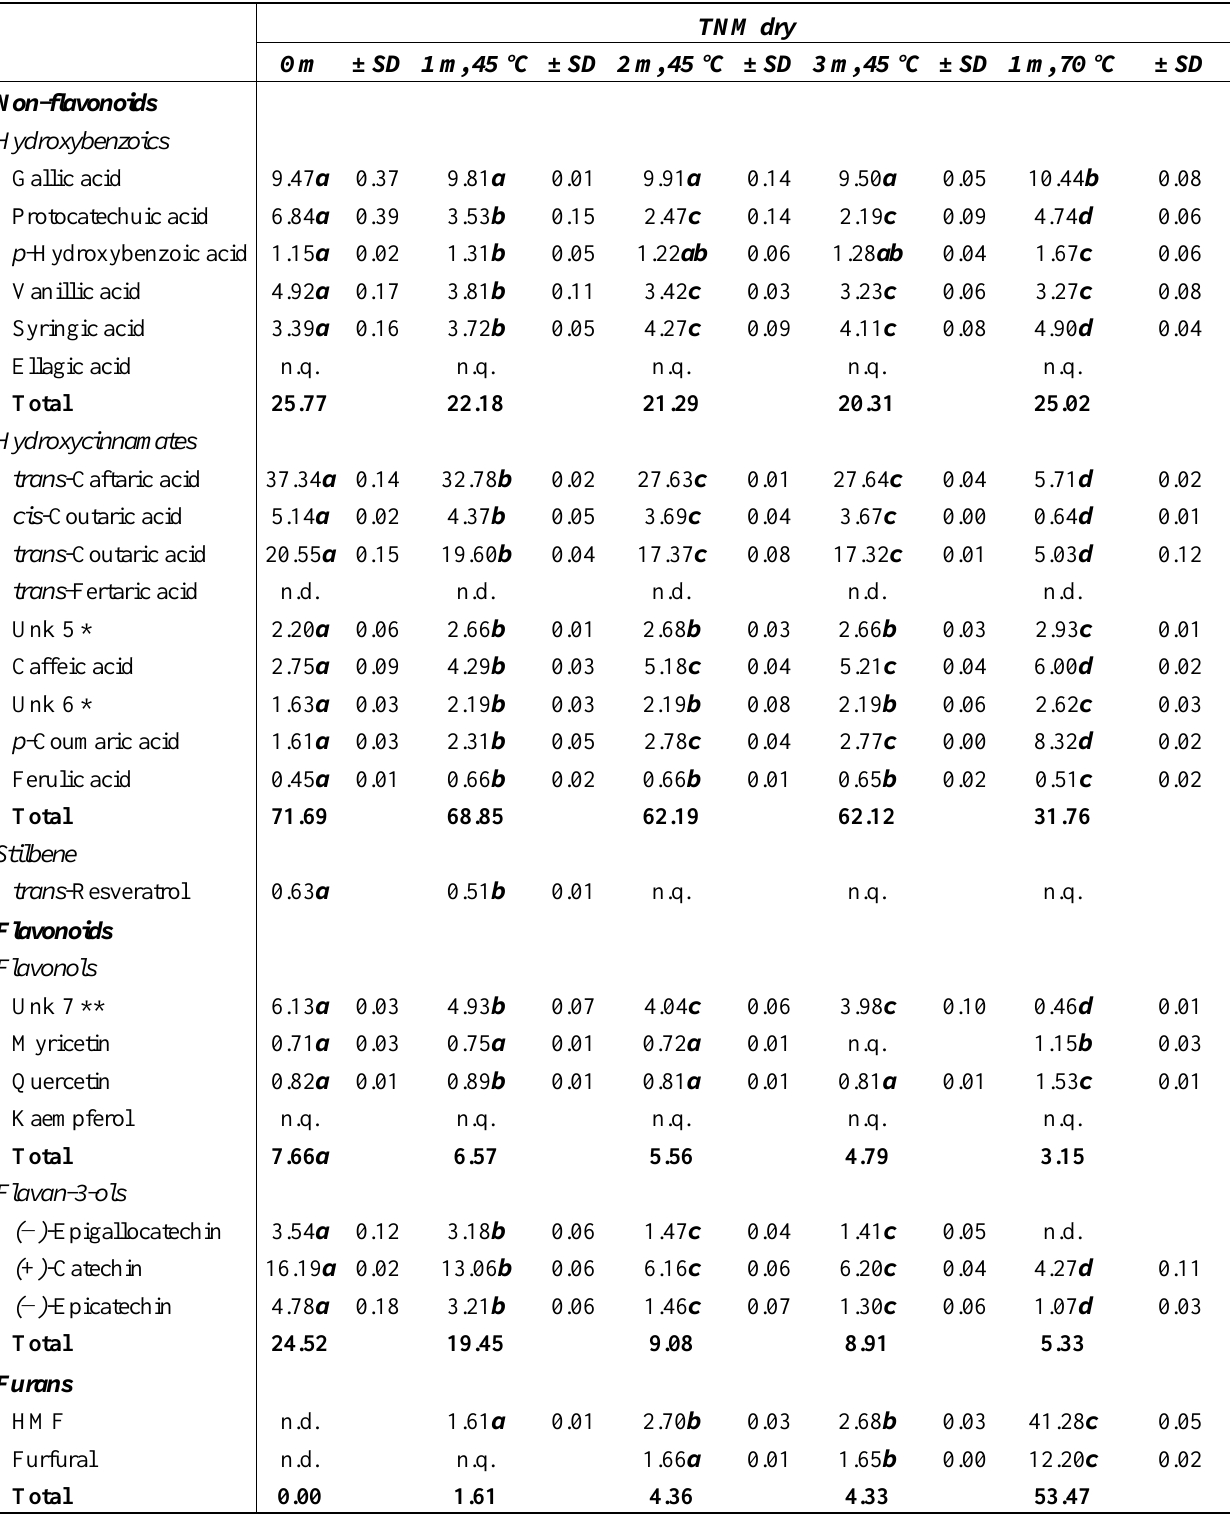
Table 3. Individual polyphenols and furans (mg/L) in TNM dry wine during heating at 45 °C (3 months) and 70 °C (1